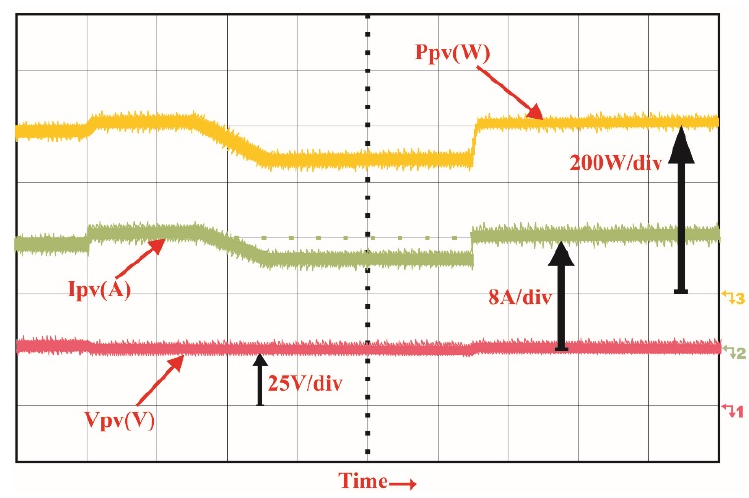
Figure 11. Experimental results ( a ) during a step ‐ changed in wind speed; ( b ) wind power; and( c ) Duty cycle of Cuk converter.